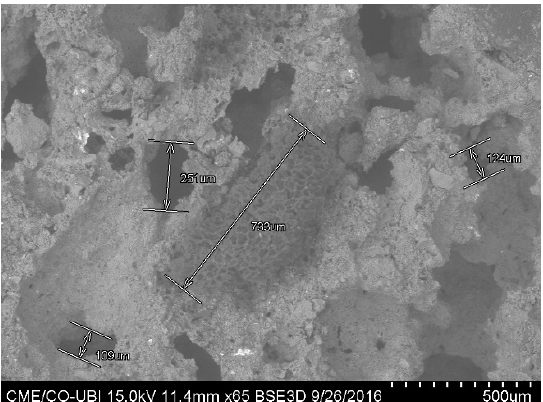
Figure 8. Photographs of the samples’ central foam section with a small (0.009 w.%) and large (0.05 w.%) amount of Al powder AA-LFM.